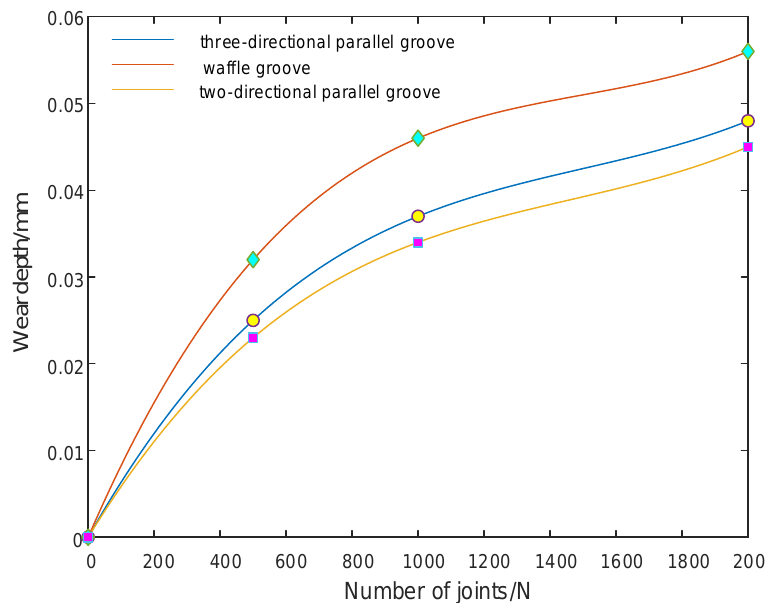
Figure 13. The relationship between the wear depth of the three shapes of grooves and the engagement.